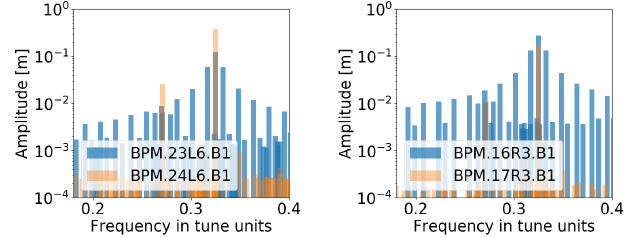
FIG. 14. Examples of the faulty BPM signal spectra in the vertical plane (blue) compared to the spectra of normal func- tioning BPMs (orange). The measurement is performed on beam 1, β (cid:2) ¼ 65 cm.